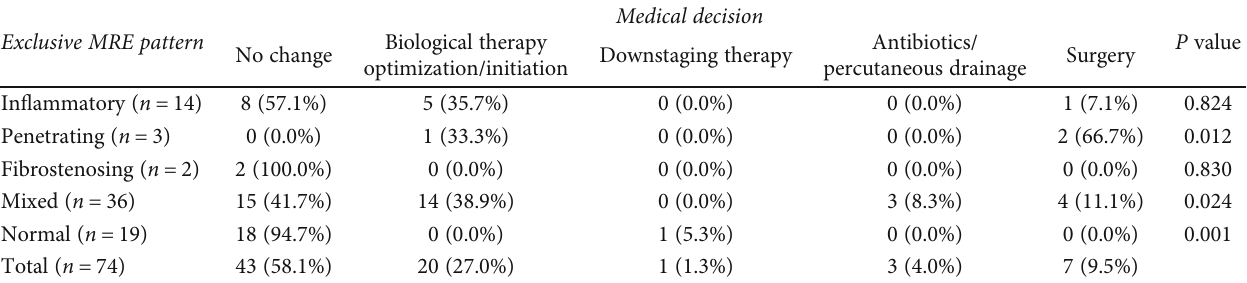
Table 2: In fl uence of disease strati fi cation based on magnetic resonance enterography in medical decisions. Exclusive MRE